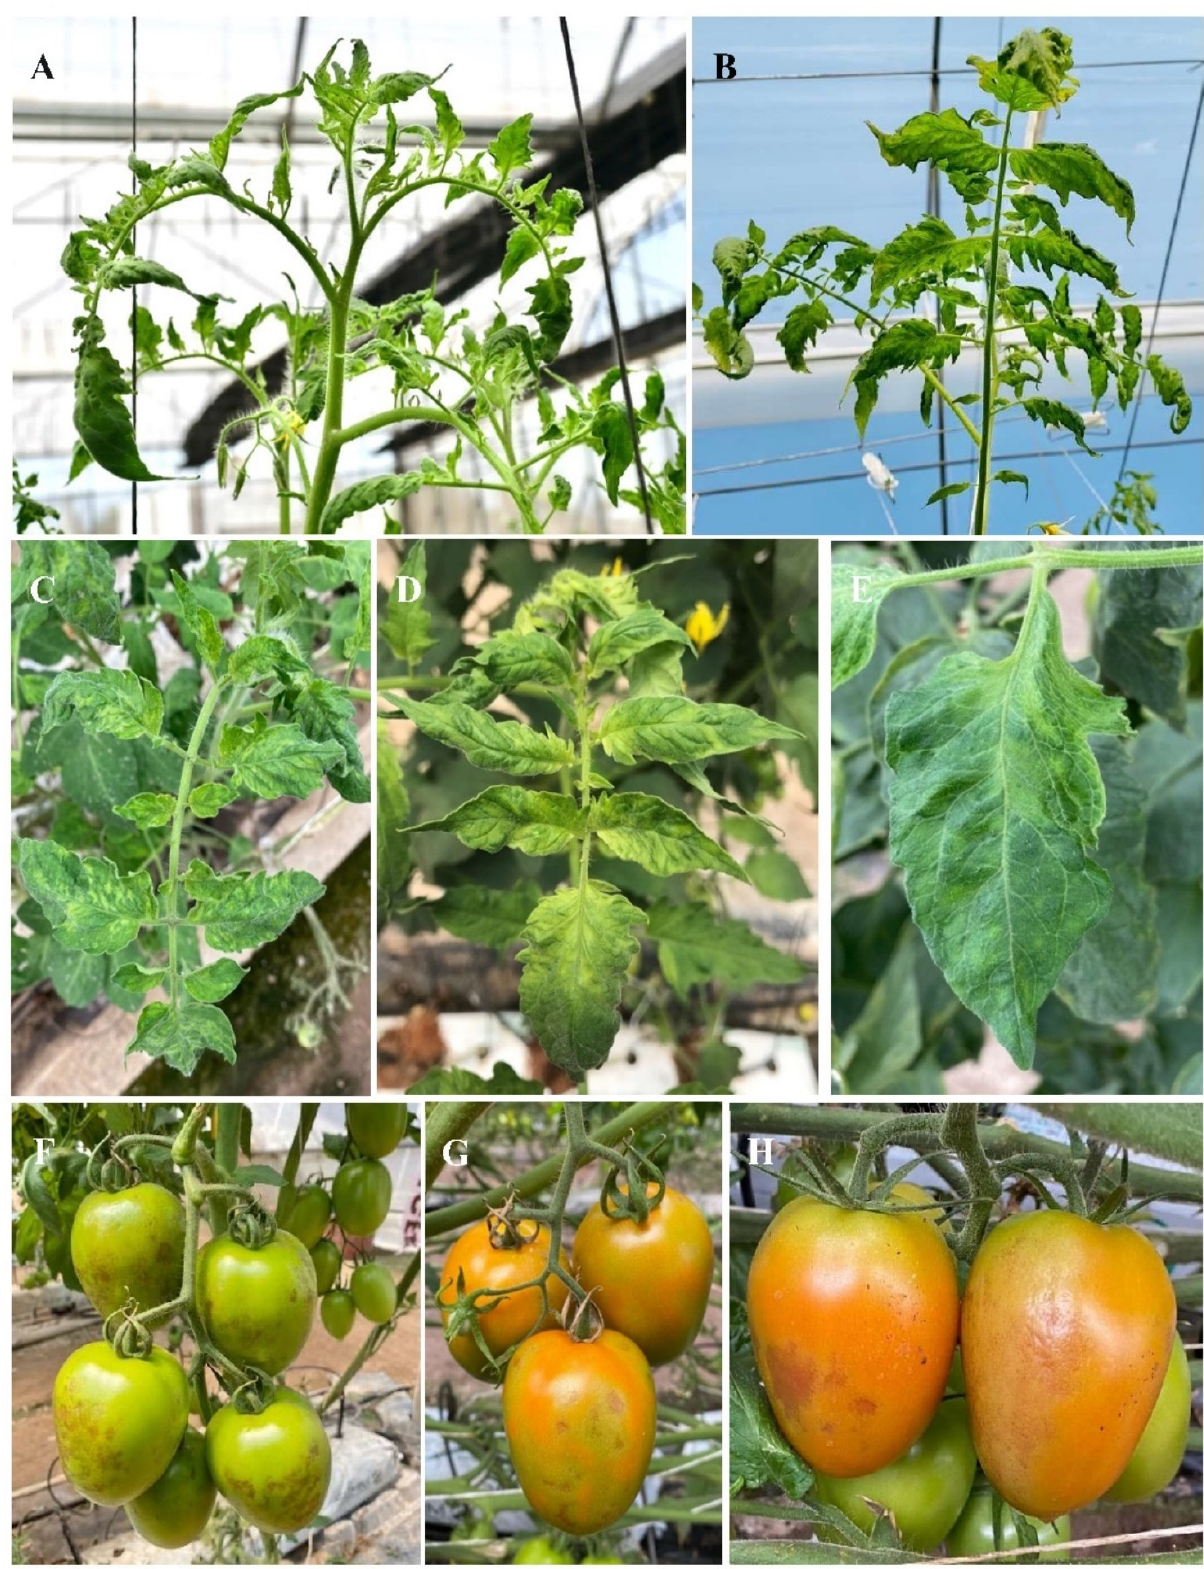
Figure 1. Symptoms caused by tomato brown rugose fruit virus on tomato plants. ( A , B ) Symptoms in apical growth point. ( C , D ) Leaflets with mosaic patterns and deformations. ( E ) Leaflets with mosaic patterns and a reduction in the leaf blade. ( F – H ) Fruits with brown spotting and necrosis in calyxes.